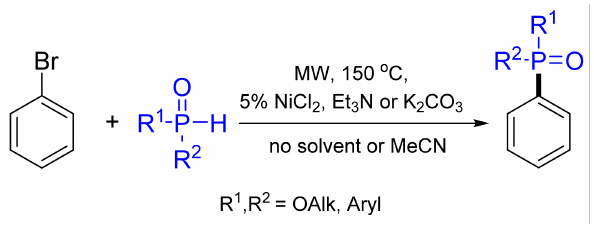
Figure 37. NiCl 2 -catalyzed phosphonylation.